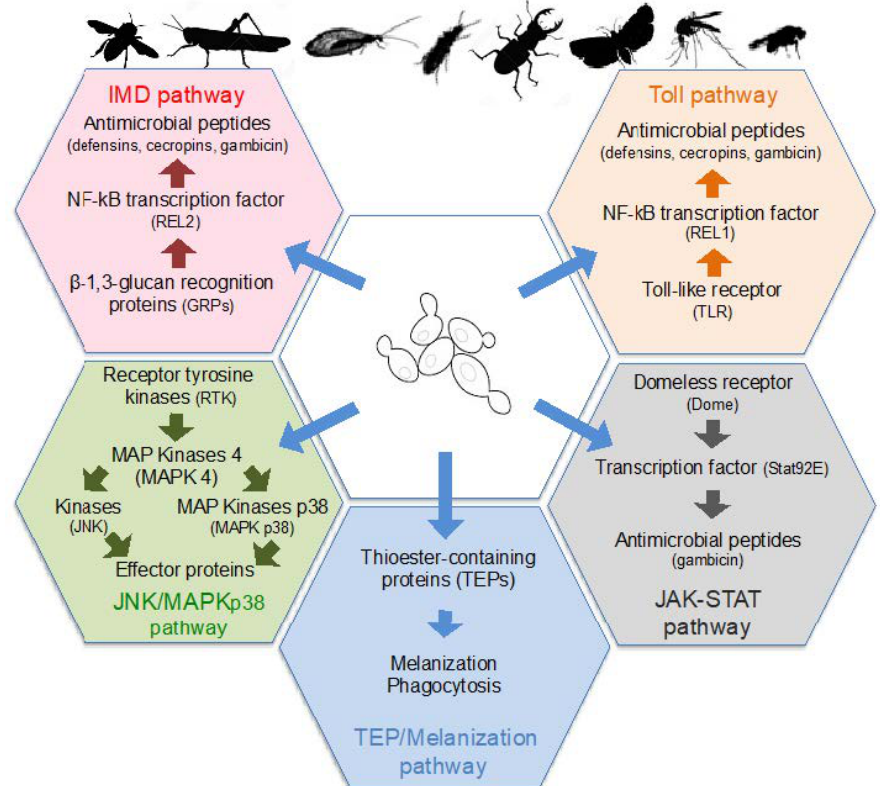
Figure 2. Signaling pathways of insects’ innate immunity stimulated by yeast colonization. Yeast surface molecules or secondary metabolites are recognized by specific receptors. This recognition induces the activation of kinases or transcription factors that stimulate the production of antimi- crobial peptides or other effector proteins, as well as phagocytosis of yeast cells and melanization. These signaling pathways stimulated by yeast are Toll, Imd (Immune deficiency), JAK/STAT (Janus Kinase/Signal Transducer), JNK/MAPKp38 (Jun N-terminal Kinase/Mitogen Activated Protein Kinase p38), TEP (ThioEster-containing Protein), and